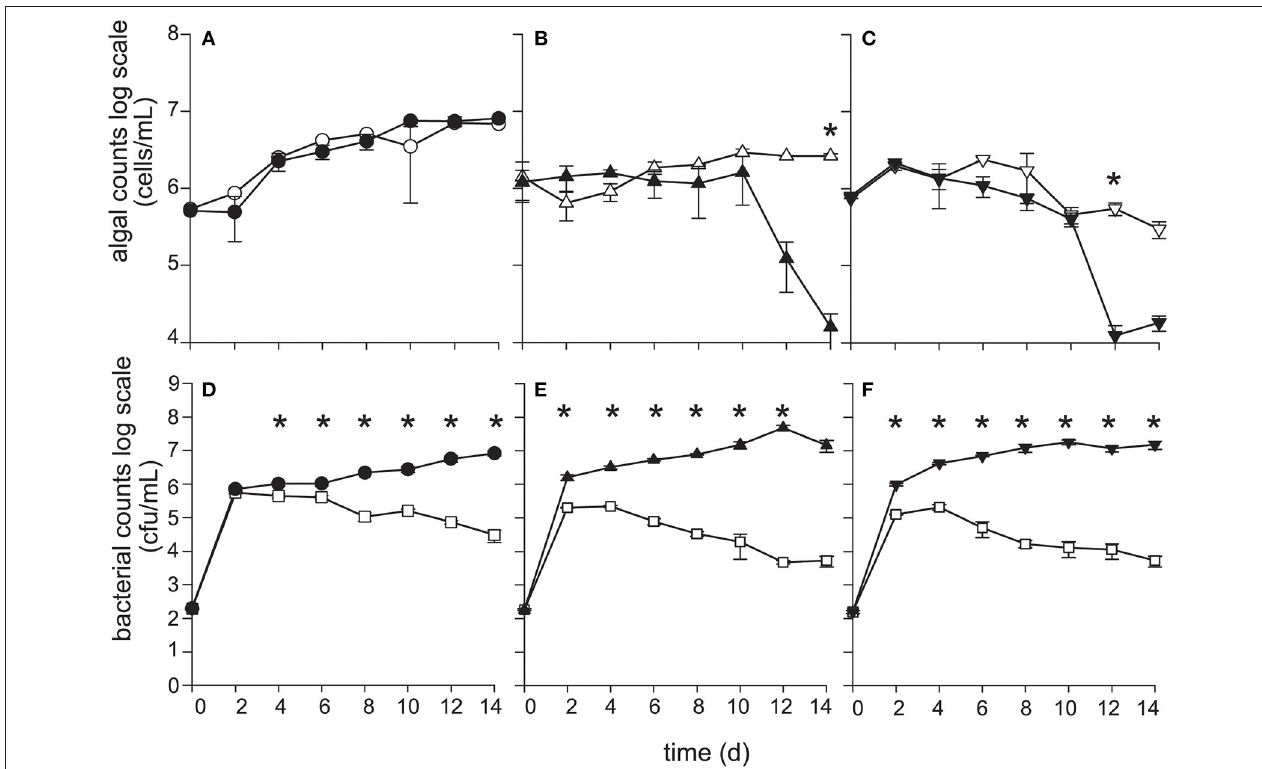
FIGURE 3 | P. inhibens kills diploid calcifying C (CCMP3266), and haploid S (CCMP3268) E. huxleyi while non-calcifying diploid N (CCMP2090) is resistant to P. inhibens pathogenesis . E. huxleyi cell density (cells · mL − 1 ) were enumerated using flow cytometry for (A) CCMP2090 (circles), (B) CCMP3266 (triangles), and (C) CCMP3268 (upside down triangles) for both axenic control (white) and grown in co-culture with P. inhibens (black). P. inhibens cell density (CFU · mL − 1 ) were enumerated for the control in L1-Si medium (white squares) and co-cultured with E. huxleyi : (D) CCMP2090 (black circles) (E) CCMP3266 (black triangles), and (F) CCMP3268 (black upside down triangles). Triplicate wells that represent independent experiments were sacrificially sampled at each time point; error bars represent ± 1 standard error. An asterisk (*) at a time point indicates that it is significantly different to the control. Statistical significance was determined using a one-way ANOVA and Tukey HSD